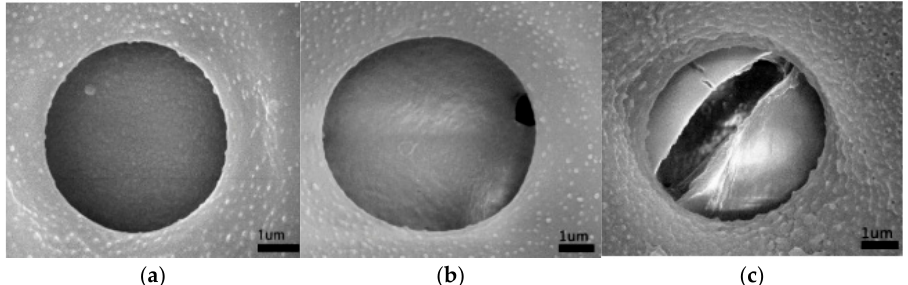
Figure 8. Scanning electron microscopy (SEM) images showing the bordered pits for different samples: ( a ) control, ( b ) low intensity, and ( c ) high intensity, according to [19].